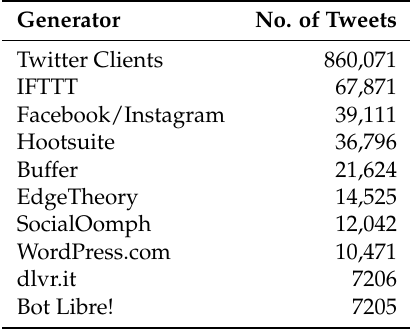
Table 4. Most Frequently Used